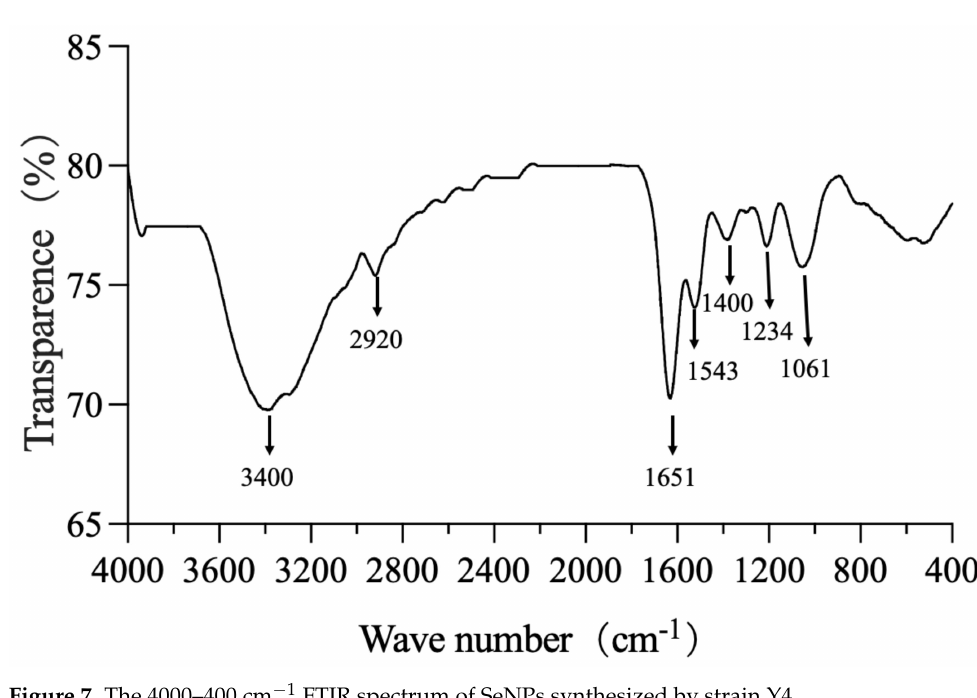
Figure 7. The 4000–400 cm − 1 FTIR spectrum of SeNPs synthesized by strain